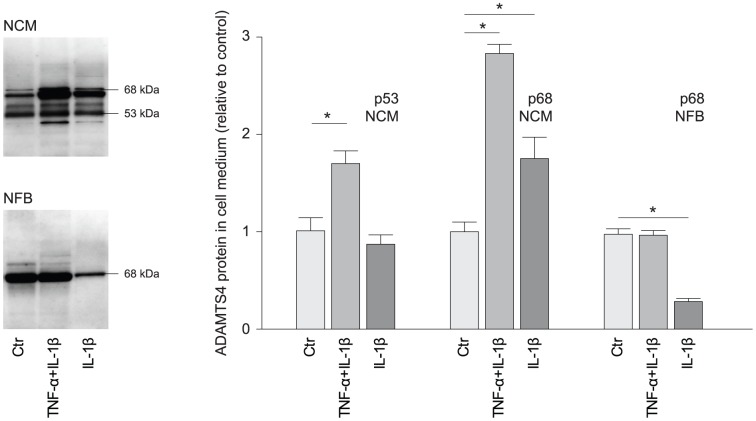
Altered ADAMTS4 protein levels in cell medium from cardiac cells after stimulation with inflammatory mediators.Protein levels of ADAMTS4 active forms (p68 and p53) in cell medium after stimulation of IL-1β alone (NFB n = 4, NCM n = 3) and in combination with TNF-α (NFB n = 3, NCM n = 4), relative to controls (n = 4). The bars represent mean levels and the error bars SEM. *p<0.05. NFB, neonatal fibroblasts; NCM, neonatal cardiomyocytes; LPS, lipopolysaccharide; IL, interleukin; TNF, tumor necrosis factor.